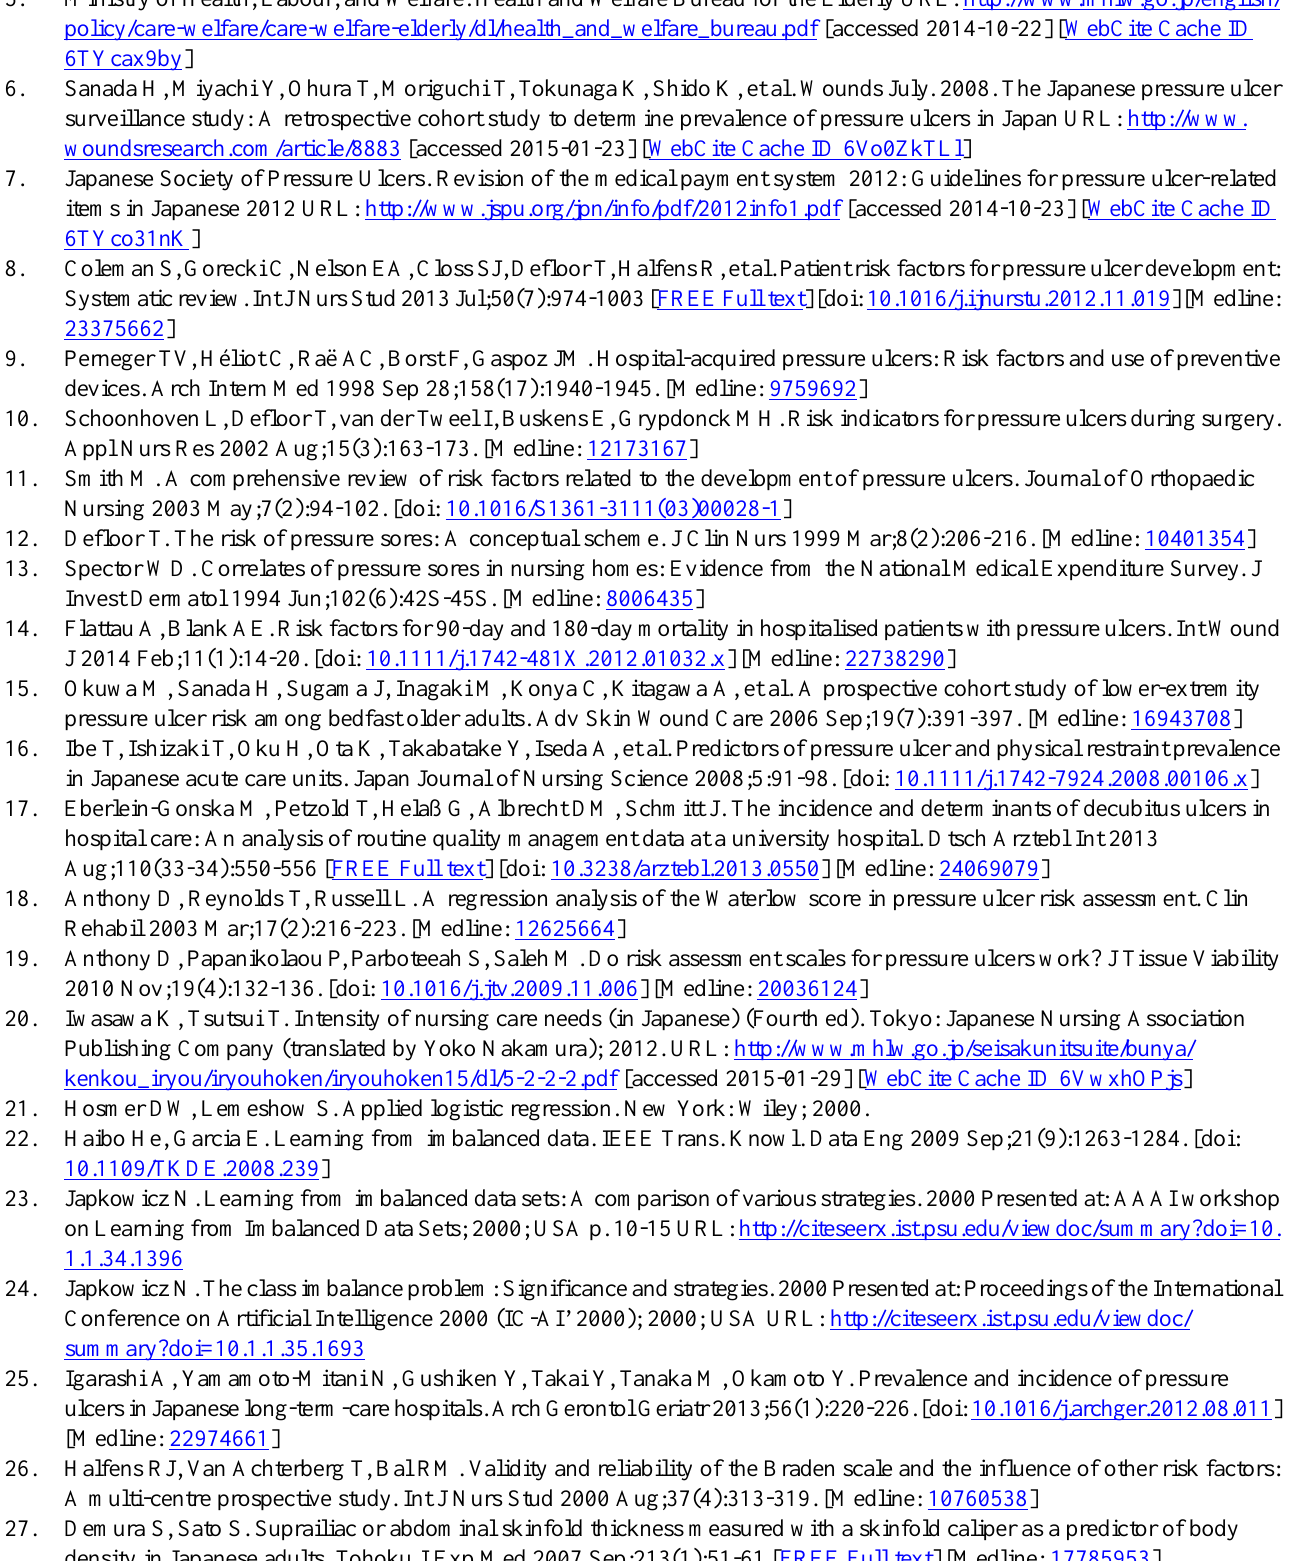
Abbreviations AUC: area under receiver operating characteristic